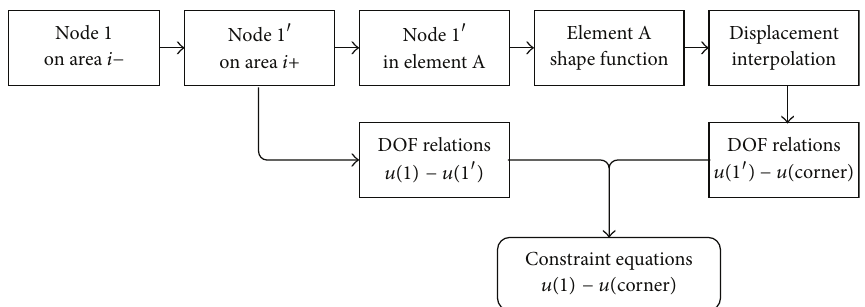
Figure 9: Method for applying constraint equations for opposite areas with dissimilar mesh patterns.